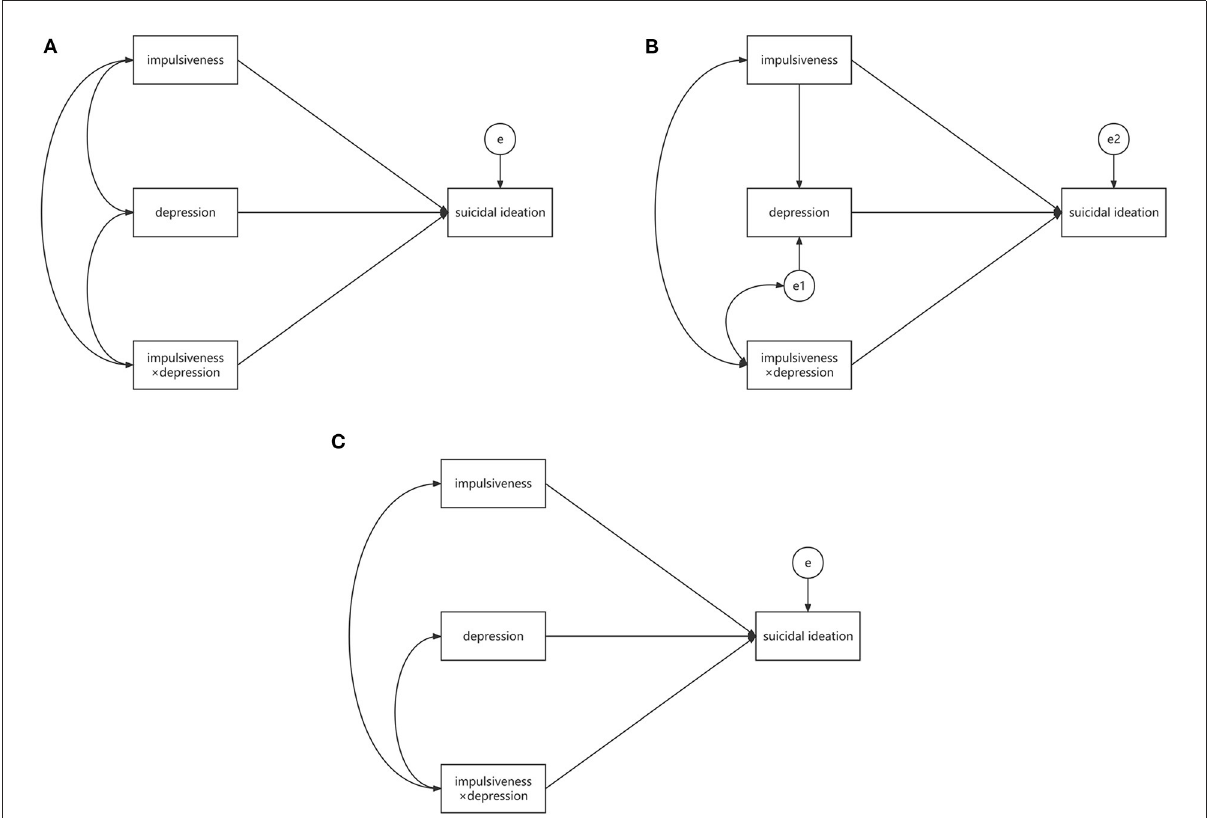
FIGURE2 Statistical diagrams of baseline model (A) , MODMEDPM (B) , and SMODPM (C) . MODMEDPM—moderated mediation path model; SMODPM—simple moderation path model; “impulsiveness × depression”—the interaction term; “e”, “e1” and “e2”—the residual variances of dependent